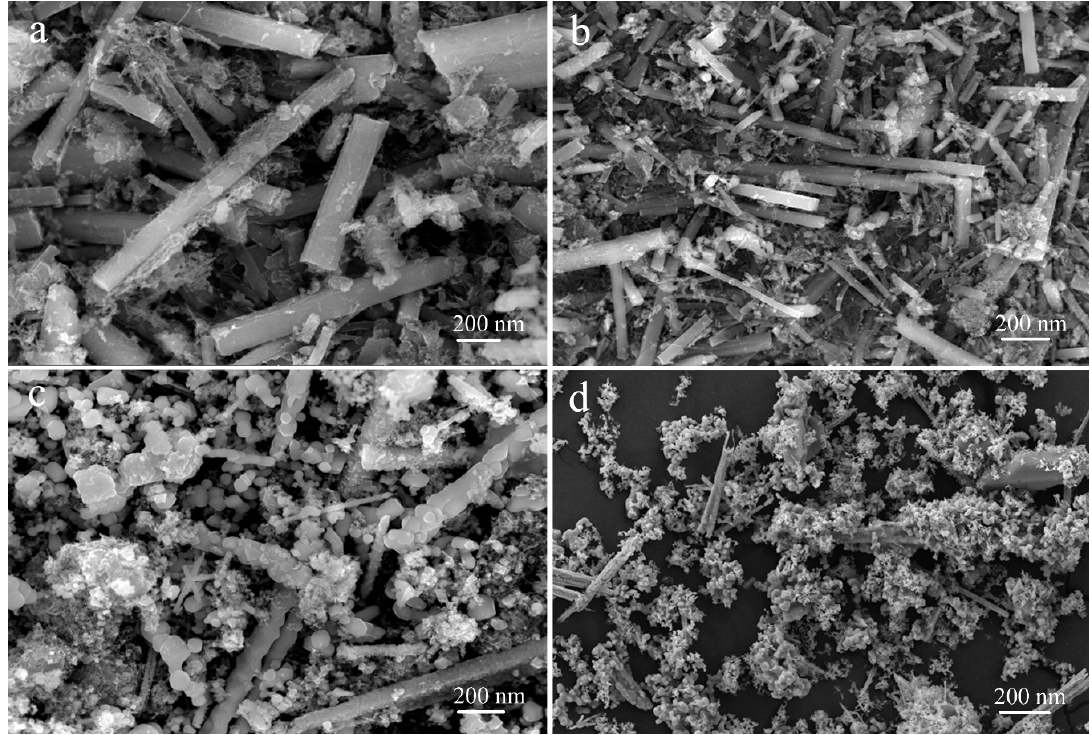
Figure 3. Images of MnO-2 ( a ), MnO-4 ( b ), MnO-6 ( c ) and MnO-24 ( d ).